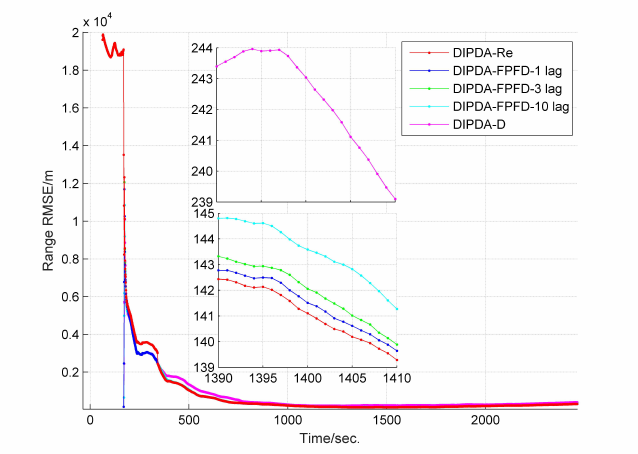
Figure 7. Averaged number of CTTs of DIPDA-D, DIPDA-Re, DIPDA-FPFD with different lags (case 1).